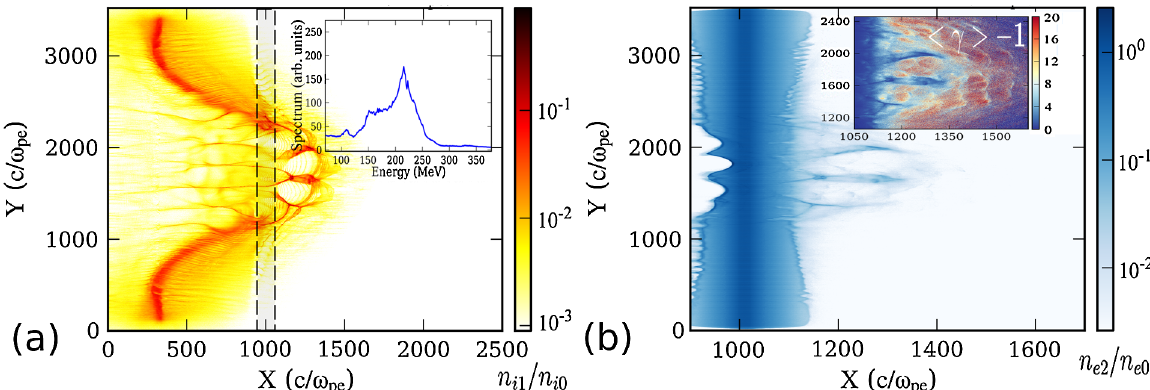
FIG. 5. (a) The first foil ion density ( n i 1 =n i 0 ) at t ¼ 175 fs . The dashed lines indicate the location of the second foil. The inset is the energy distribution of the ion beam between 1460 c=! p < y < 2060 c=! p , the ion beam has E c ¼ 207 MeV and (cid:1) E=E ¼ 31% . (b) The second foil electron density ( n e 2 =n e 0 ) showing comoving electrons. The inset is the average kinetic energy ( h (cid:1) i (cid:4) 1 ) of the second foil electrons, with cold electrons in blue and hot electrons in